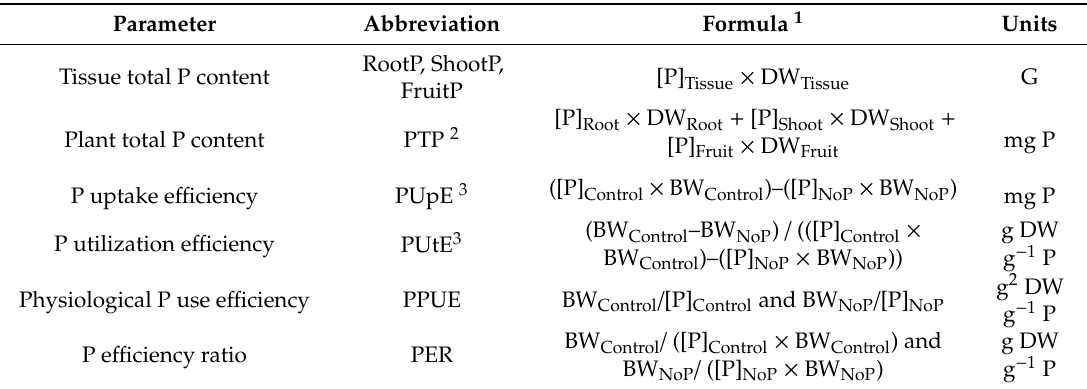
Table 2. P uptake and P use e ffi ciency (PUE) parameters used in this experiment and corresponding abbreviation, formula and expressed units. Dry weight (DW), total biomass dry weight biomass